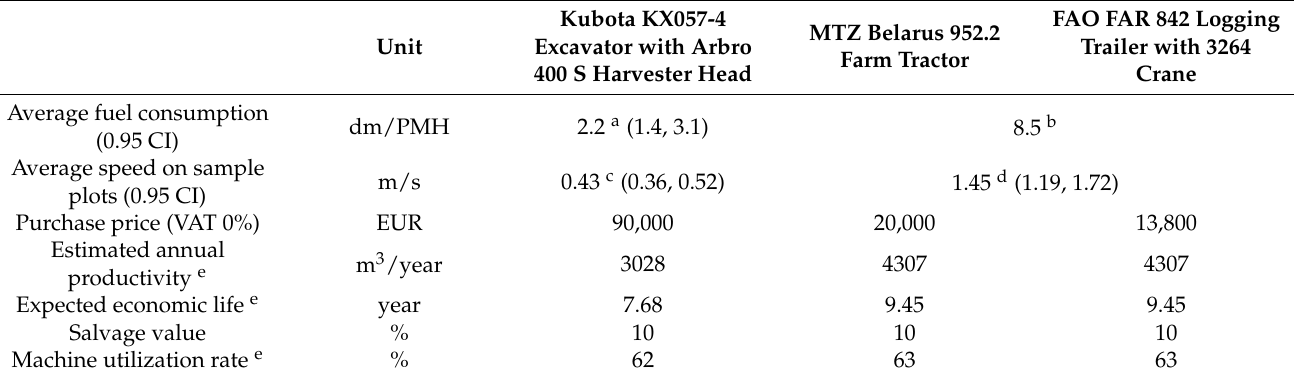
Table 3. Basic data used in cost